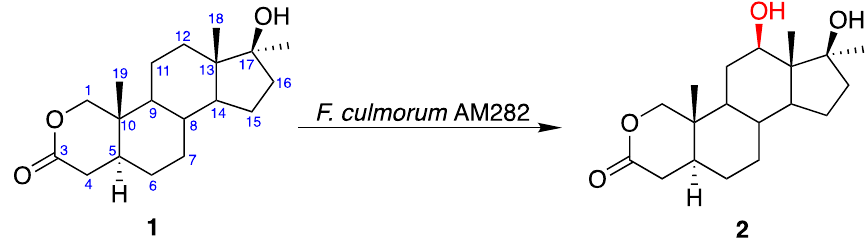
Figure 1. Transformation of oxandrolone ( 1 ) in the culture of Fusarium culmorum AM282. Table 1. Compositions of crude extracts obtained in transformations of oxandrolone ( 1 ).